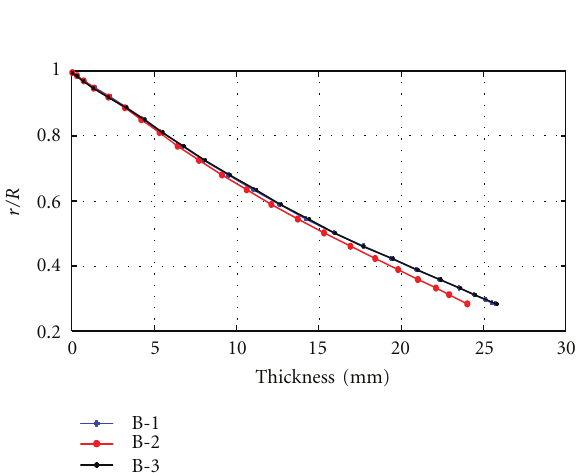
Figure 20: Thickness distribution, aft propeller.